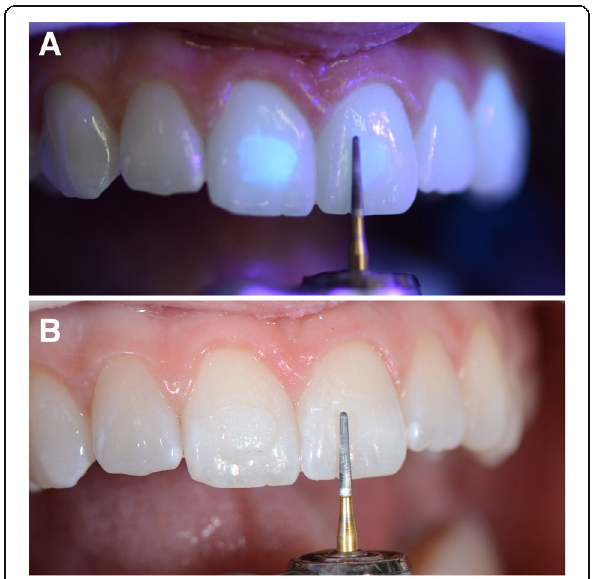
Fig. 1 Clinical perspective of adhesive remnant after debonding with UV ( a ) and conventional ( b )